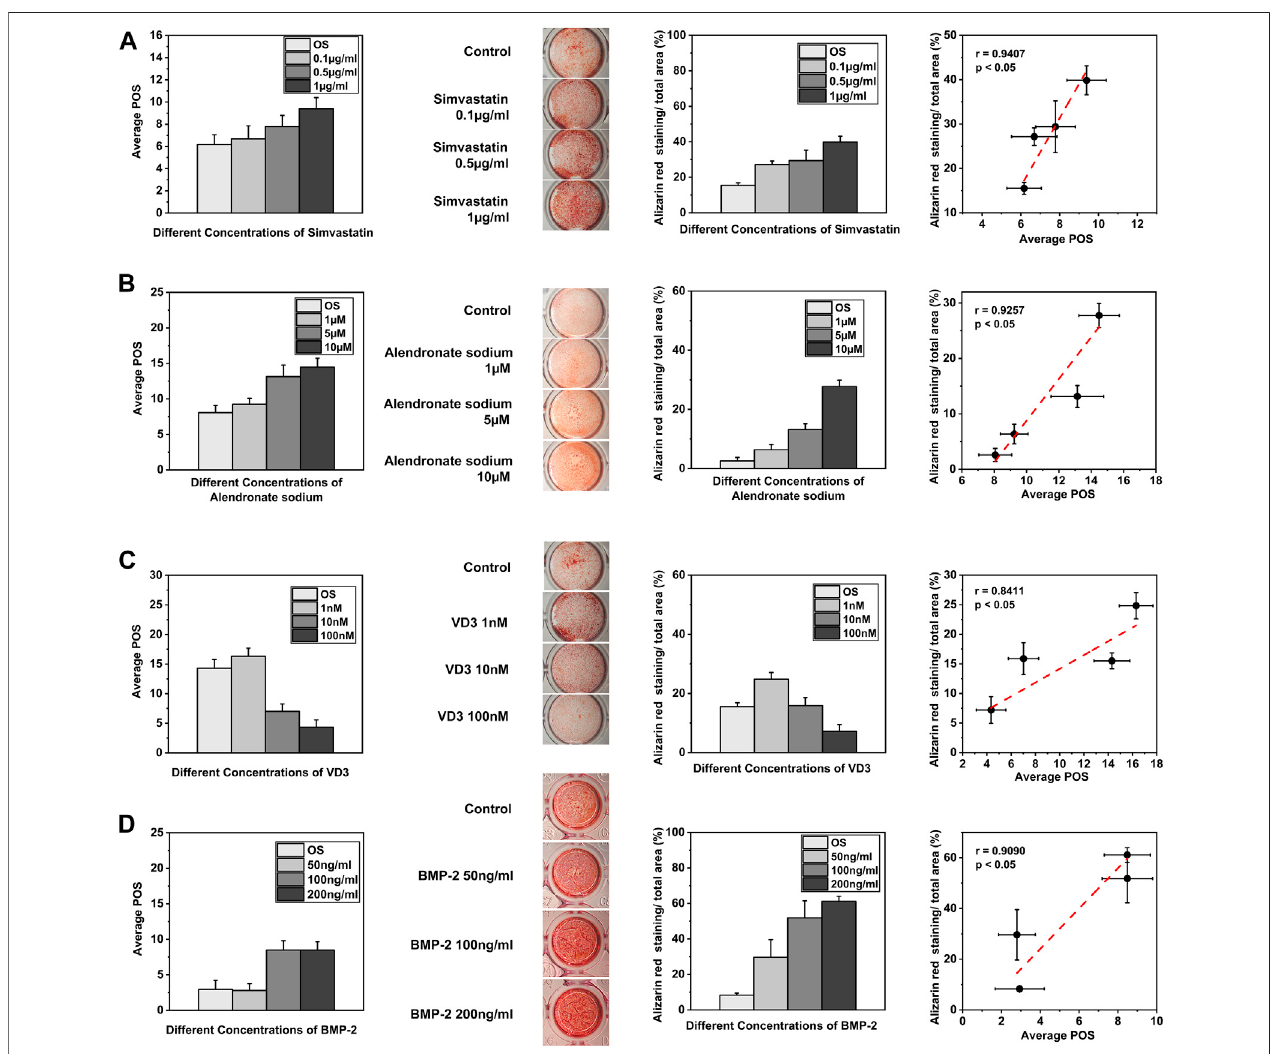
FIGURE4| OCNNfordrugscreening. (A) Thepredicted osteogenic score(POS) oftherBMSCs cultured withdifferentconcentrationsofsimvastatinonday 1and Alizarin red staining on day 14 was quanti fi ed by ImageJ. Linear fi ts were performed using the POS and Alizarin red staining areas to calculate the correlation, p ＜ 0.05. (B) The predicted osteogenic score (POS) of the rBMSCs cultured with different concentrations of alendronate sodium on day 1 and Alizarin red staining onday 14 was quanti fi ed by ImageJ. Linear fi ts were performed using the POS and Alizarin red staining areas to calculate the correlation, p ＜ 0.05. (C) The predicted osteogenic score (POS) of the rBMSCs cultured with different concentrations of VD3 on day 1 and Alizarin red staining on day 14 was quanti fi ed by ImageJ. Linear fi ts were performed using the POS and Alizarin red staining areas to calculate the correlation, p ＜ 0.05. (D) The predicted osteogenic score (POS) of the rBMSCs cultured with different concentrations of BMP-2 on day 1 and Alizarin red staining on day 14 was quanti fi ed by ImageJ. Linear fi ts were performed using the POS and Alizarin red staining areas to calculate the correlation, p ＜